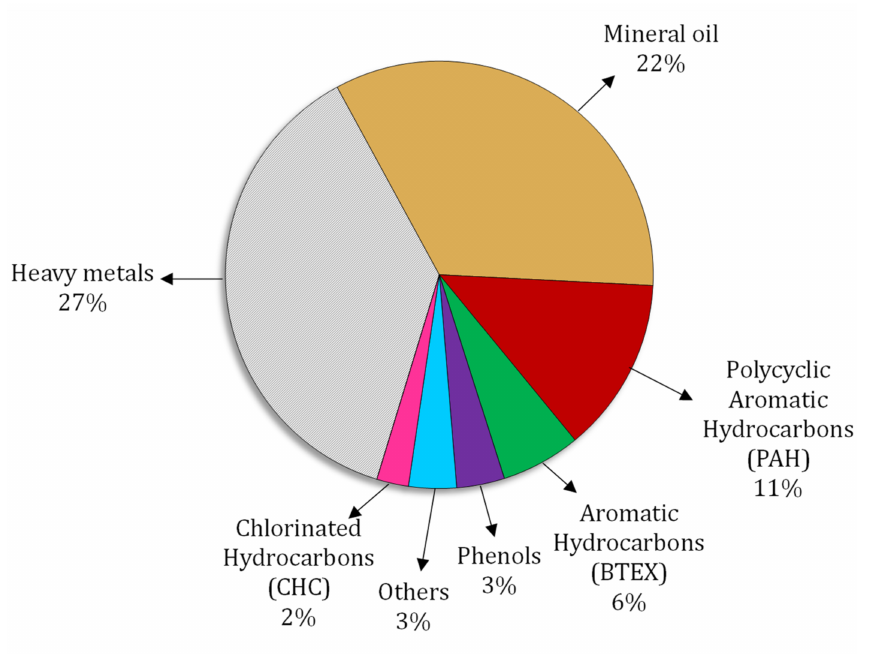
Figure 4. The main pollutants in soils, adapted from the European Environment Agency